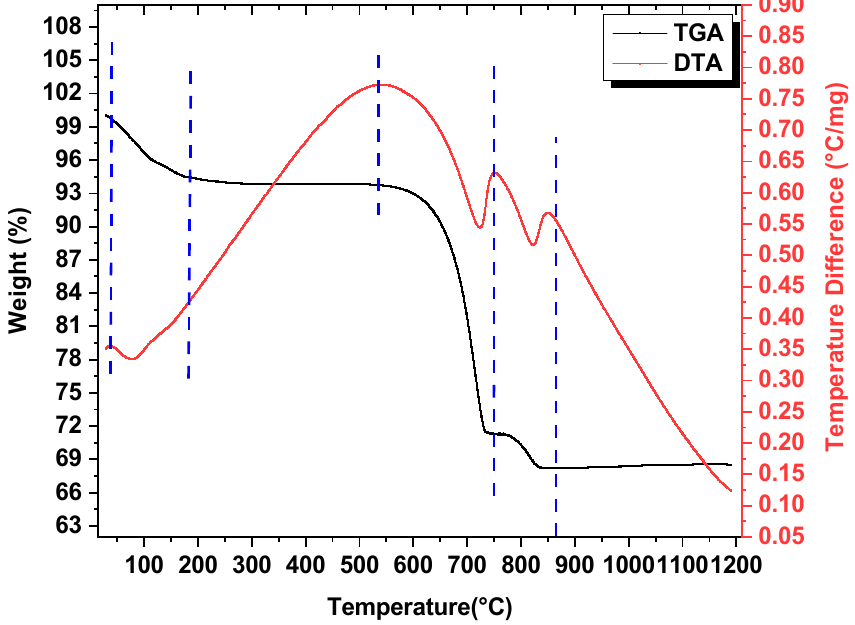
Figure 2. TGA/DTA plots. The DTA curve reaches up to a maximum of 0.78 °C/mg due to the exothermic reaction.